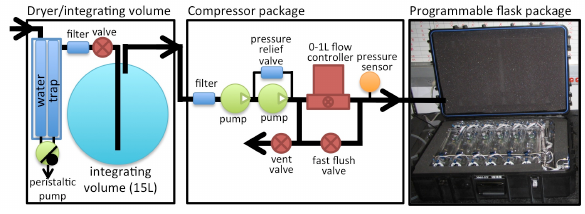
Fig. 1. Integrating compressor flask sample collection system